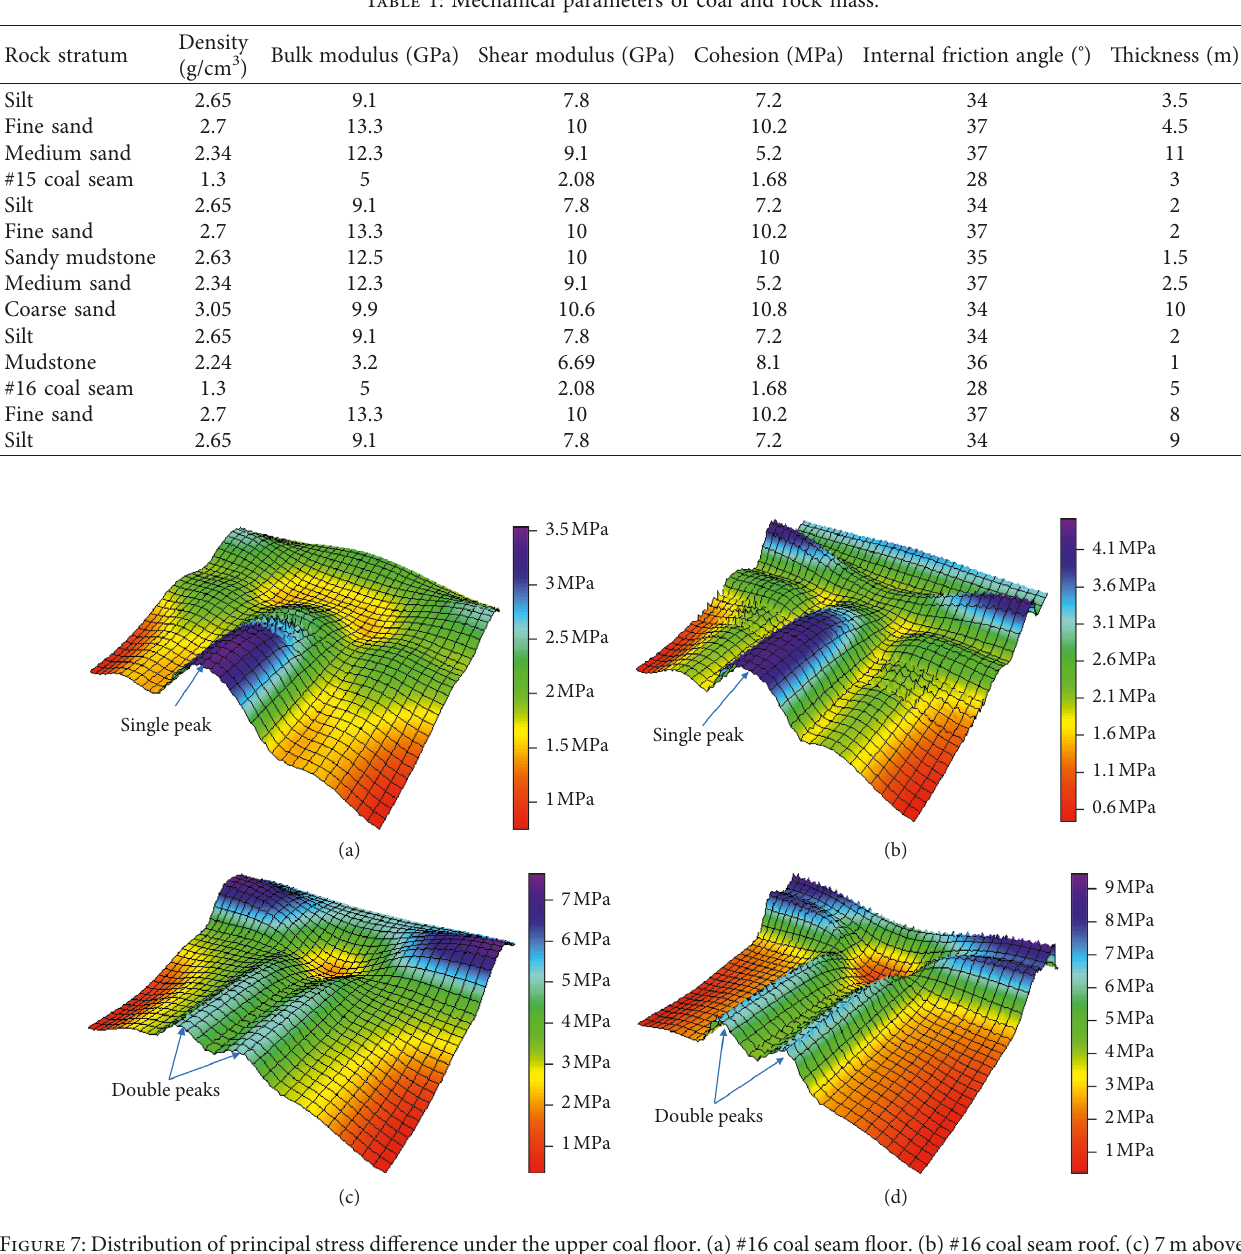
Table 1: Mechanical parameters of coal and rock mass.